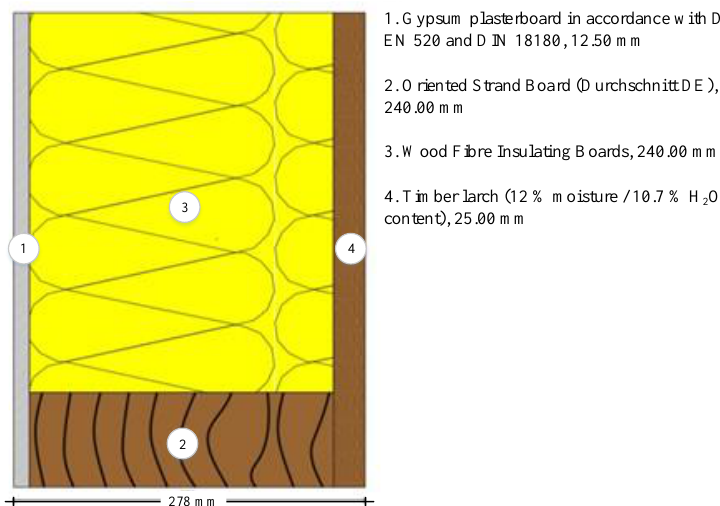
Fig. 4. Example of a graphic representation of construction layer created in eLCA